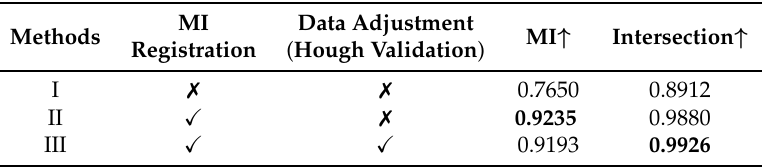
Table 2. MI and Intersection obtained by applying registration (higher values are better). n g = 1.34 bn. # patches = 1859. Note that we employ only a subset of training data due to the partial coverage of the building binary map. Best results in